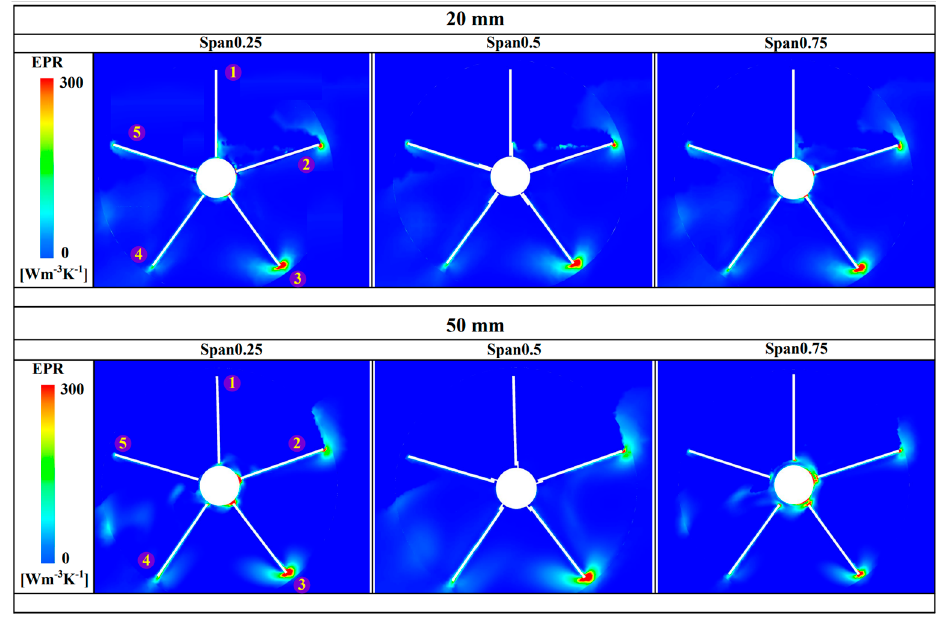
Figure 13. Distribution of EPR in the midsection of water wheels under 20 mm and 50 mm clearances.